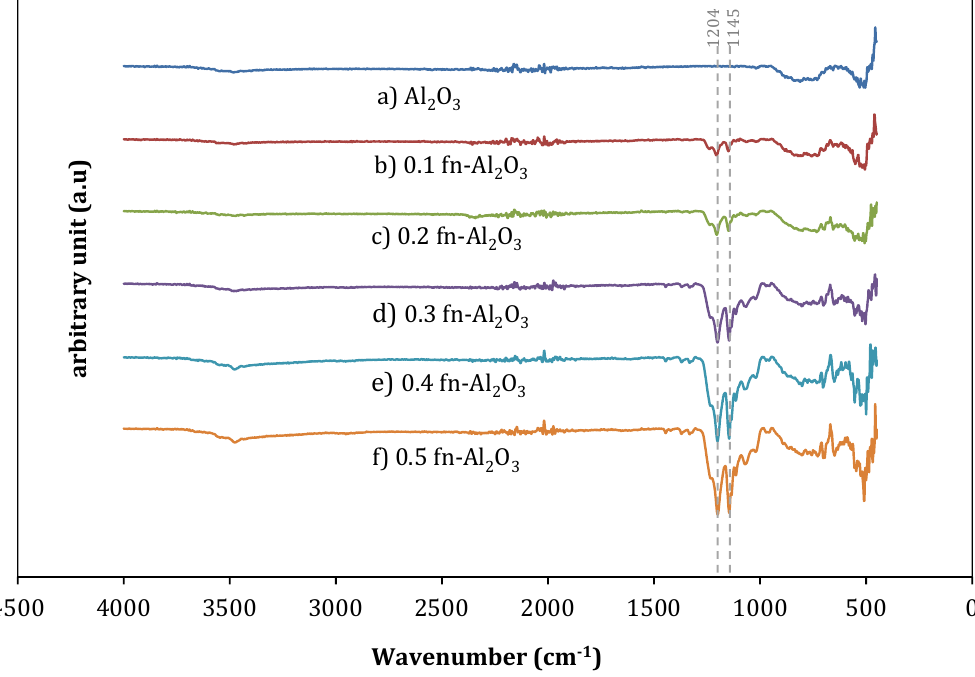
Figure 2. FT-IR spectra of a pristine nano-Al 2 O 3 ( a ) and functionalized alumina with different fluoroalkylsilane (FAS) values; ( b ) 0.1, ( c ) 0.2, ( d ) 0.3, ( e ) 0.4, and ( f ) 0.5 mL. The dotted lines show two prominent perfluorinated vibration bands.